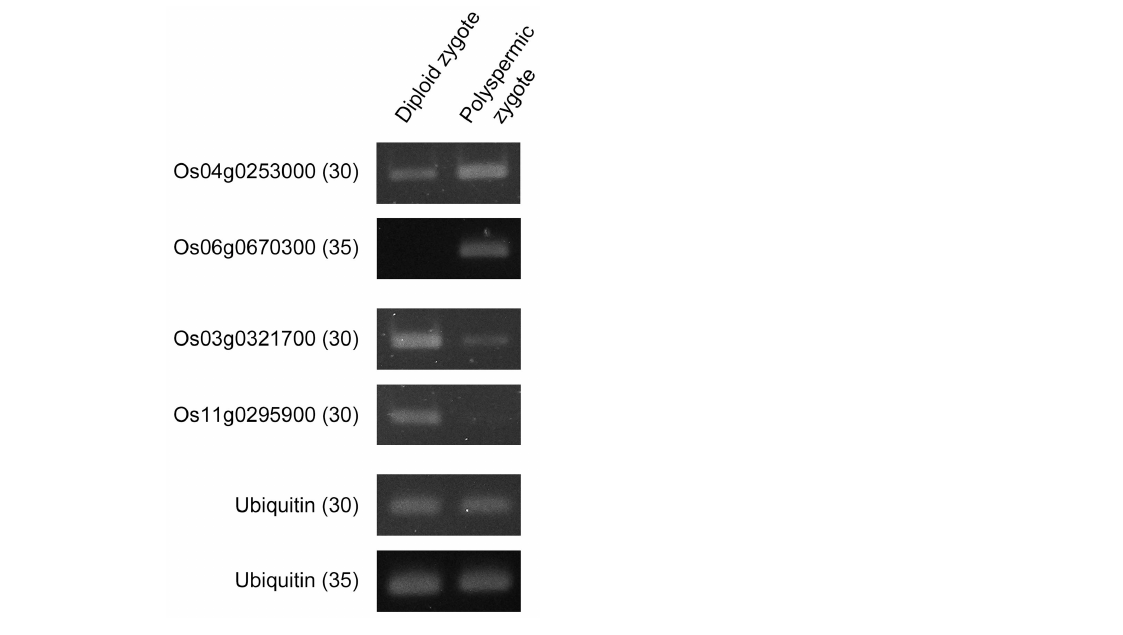
Figure 4. Expression patterns of 4 genes whose expression levels were putatively up- or down- regulated in polyspermic zygotes. Semi-quantitative RT-PCR was performed on cDNAs synthe- sized from diploid and polyspermic zygotes using specific primers for the putatively up-regulated genes, Os04g0253000 and Os06g0670300 (Table 2) and down-regulated genes, Os03g0321700 and Os11g0295900 (Table 3) in polyspermic zygotes. Ubiquitin cDNA was used as an internal control. Numbers in parentheses indicate the number of PCR cycles. Primer sequences are presented in Supplementary Table S5. Table 2. Identified genes whose expression levels were putatively up-regulated in polyspermic